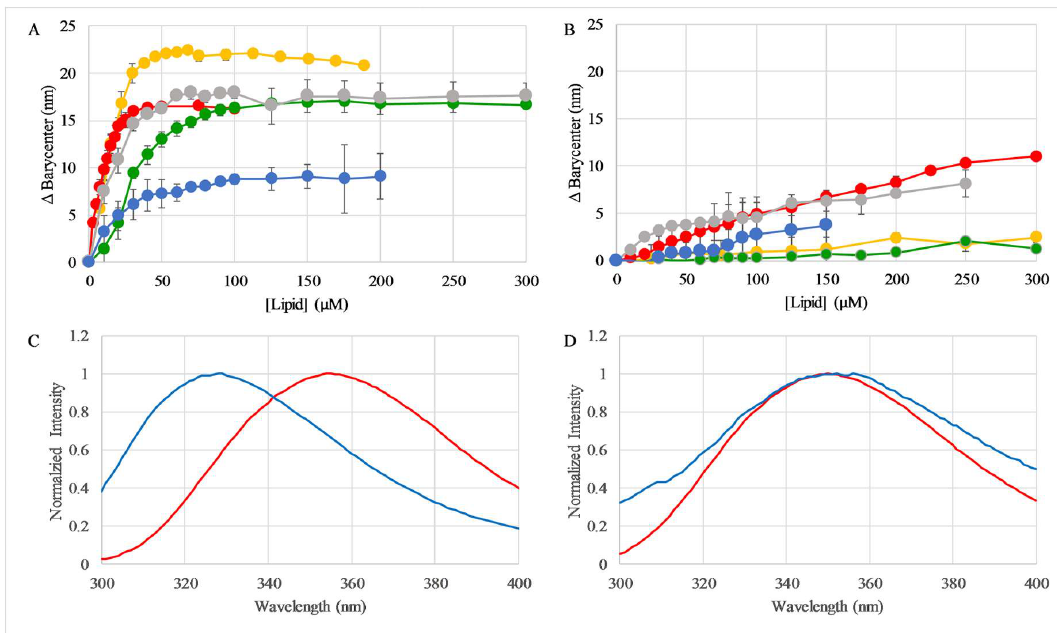
Figure 2. Trp fluorescence emission to measure peptide binding to vesicles. Samples containing 2 µM peptide in phosphate buffered saline (PBS) were titrated with either ( A ) 3:1 PC/PG or ( B ) 100% PC lipid vesicles. Trp emission barycenter was calculated after each addition of vesicles and plotted as a function of total lipid concentration. In both panels, colors represent C18G (green), C18G-Arg (red), C18G-His (gray), C18G-Orn (orange), C18G-Dap (blue). All data is the average of 2–5 replicates, and error bars represent standard deviations. Representative normalized spectra of C18G from panels A and B are shown in C and D , respectively. In both C and D , red spectra represent Trp emission in the absence of lipid, blue represents spectra when bound to 300 µM lipid. All data presented is after background subtraction and dilution correction when appropriate.